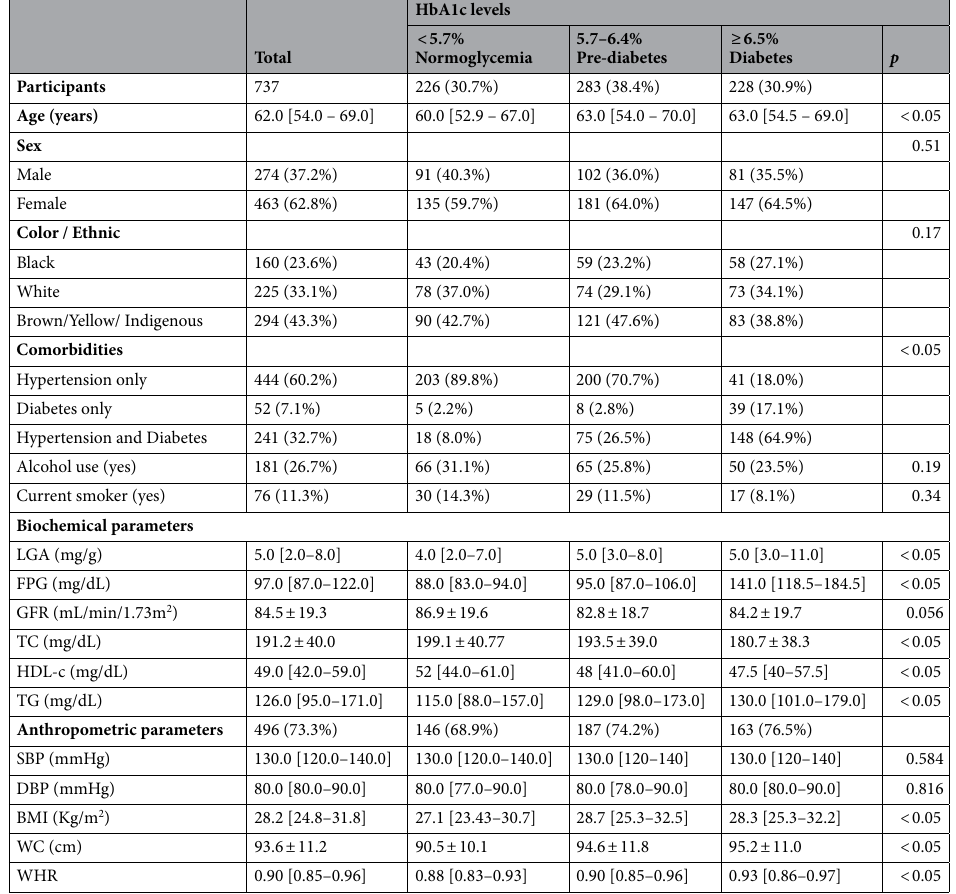
variables. The p values were calculated using the Annova test and kruskal kal wals for continuous variables and χ 2 test for categorical variables. LGA, low-grade albuminuria; BMI, body mass index; GFR, glomerular filtration rate; FPG, fasting blood glucose; HbA1c, glycated hemoglobin A1c; HDL-c, high density lipoprotein cholesterol; TG, triglycerides; WC, waist circumference; WHR, waist-to-hip